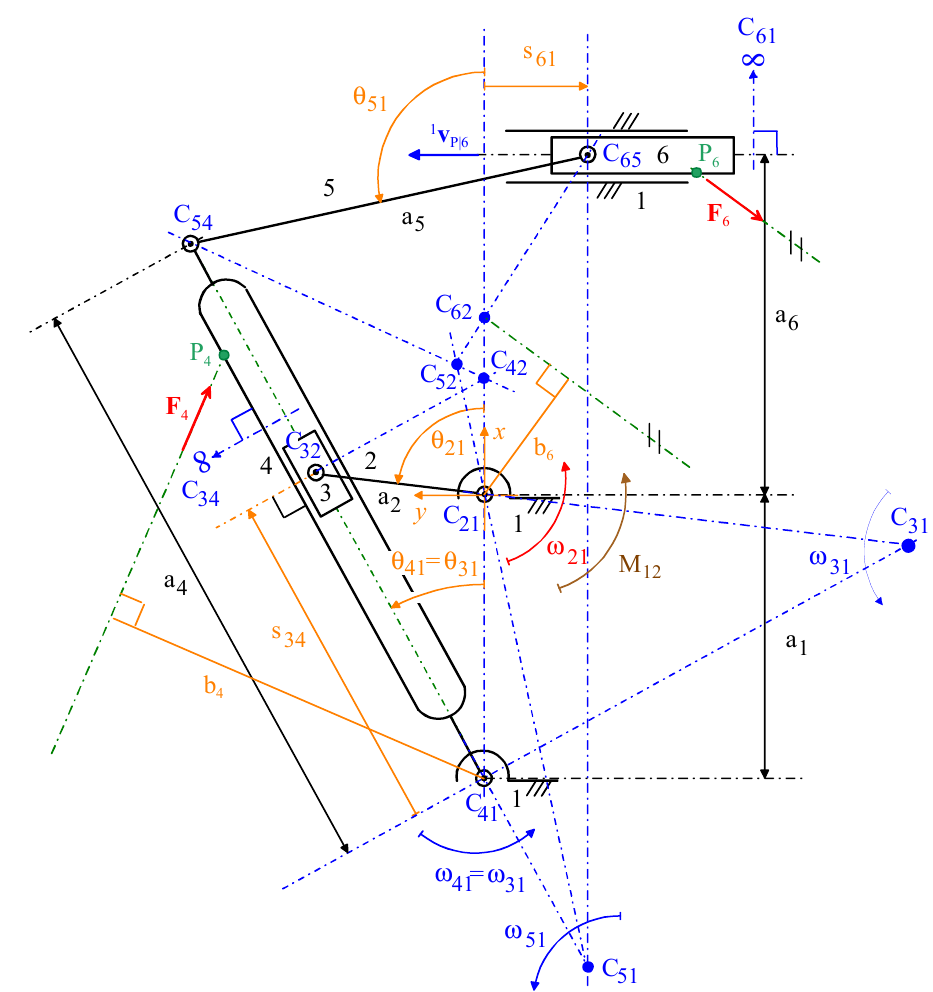
Figure 10. Active-load diagram of the shaper mechanism.